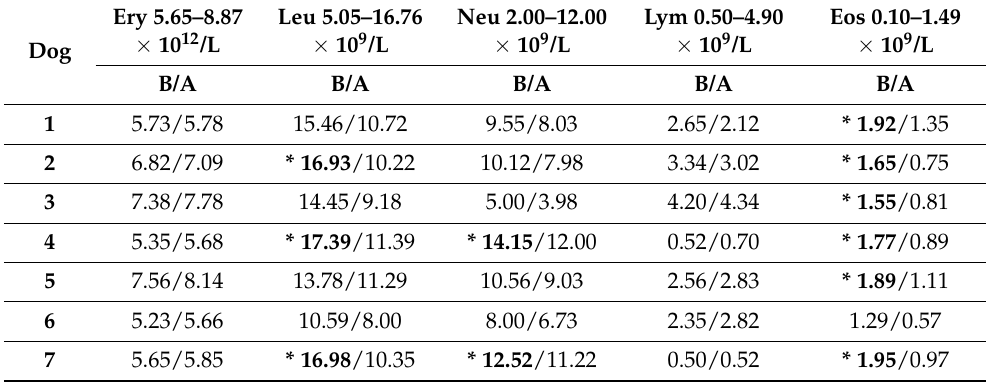
Table 3. Hematological examination before ( B ) and after ( A ) therapy in the first group of patients.